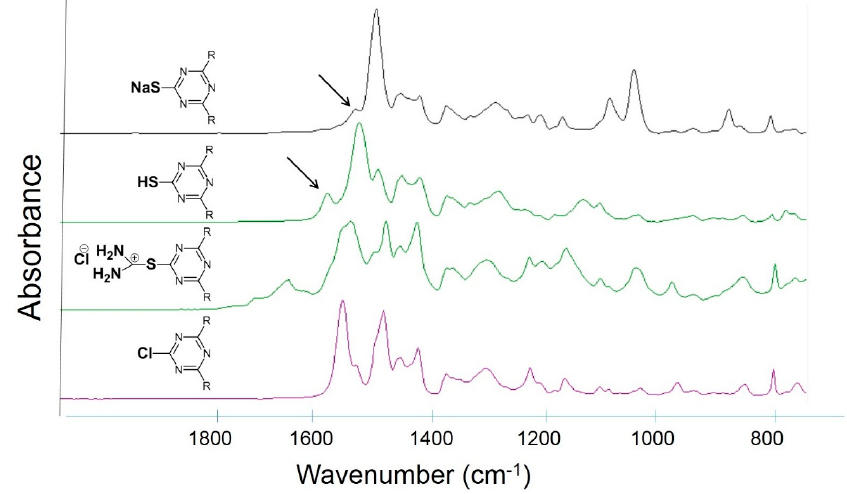
Figure 2. IR spectra of TCTA-derivatives of modifier 6 (see Table 2) being R = –N(C 8 H 17 ) 2 .